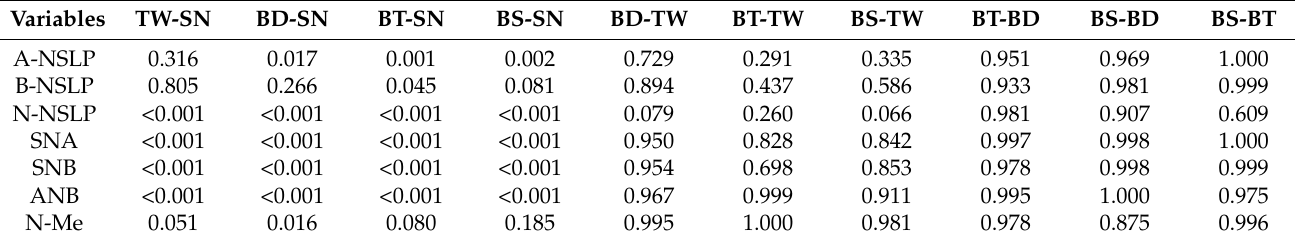
Table 3. The p -values from pairwise post-hoc tests, adjusted for multiple comparisons within each variable using Tukey’s honest significant difference method (N = 40) for the sagittal and vertical relations across five superimposition methods (T2S REF1 − T1C REF1 ), showing that the SN method differs from the other methods.